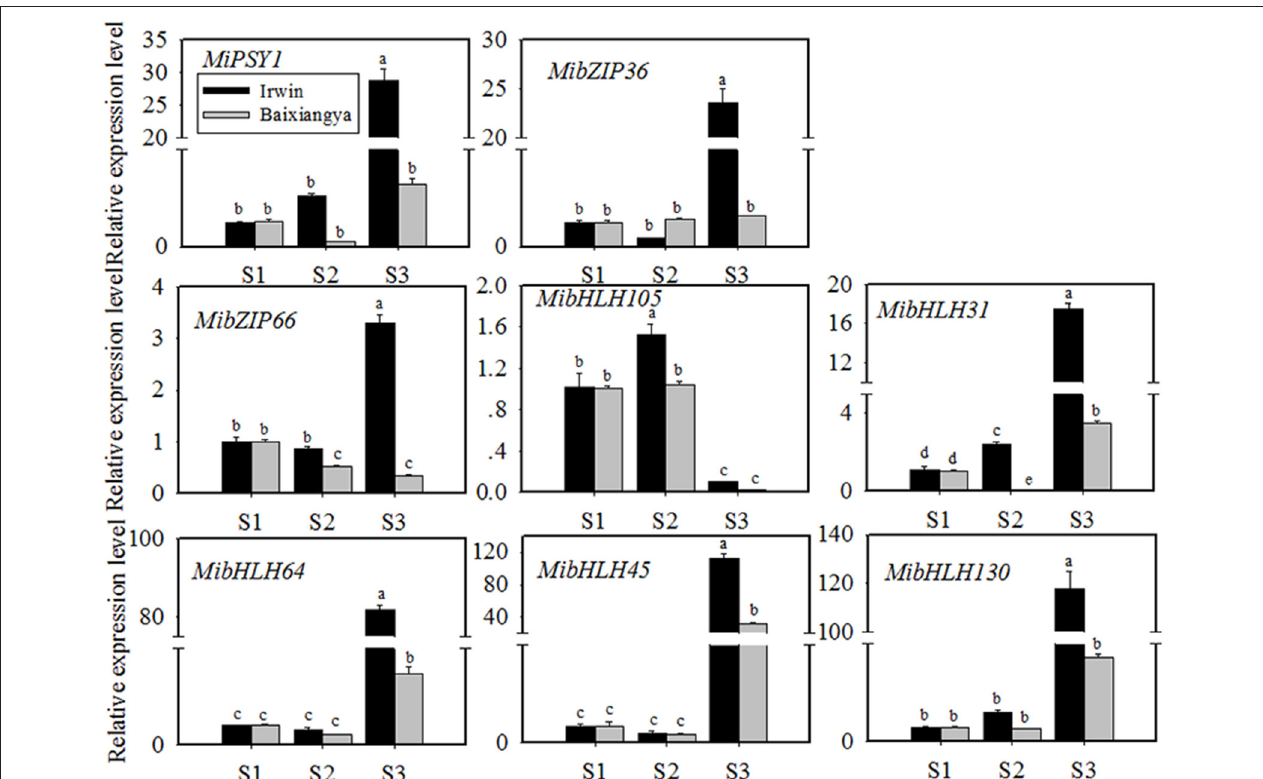
FIGURE 4 | Relative expression levels of MiPSY1 and seven selected transcription factors (TFs) in the flesh of “Baixiangya” and “Irwin” mangoes during fruit development and ripening. Gene expression levels were analyzed by quantitative reverse transcription analysis. Different letters show significant differences in expression level as calculated by Duncan statistical analysis ( p <